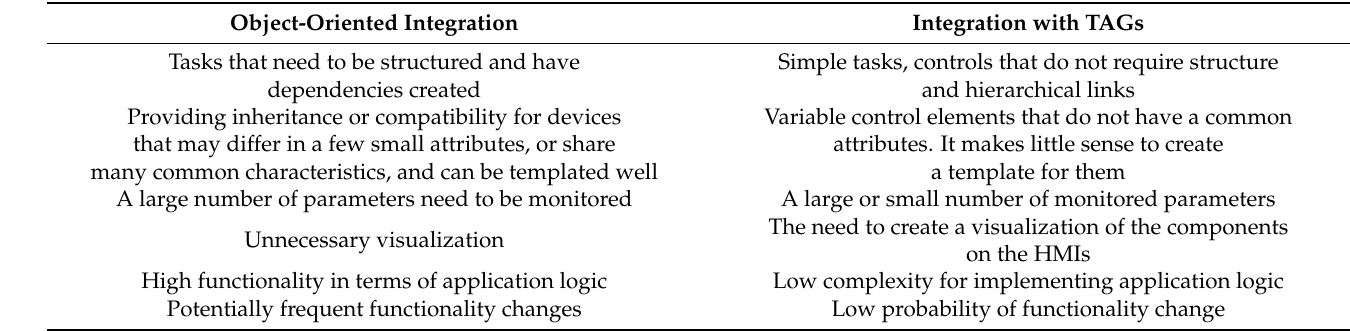
Table 2. Comparison of object-oriented and TAG integration.